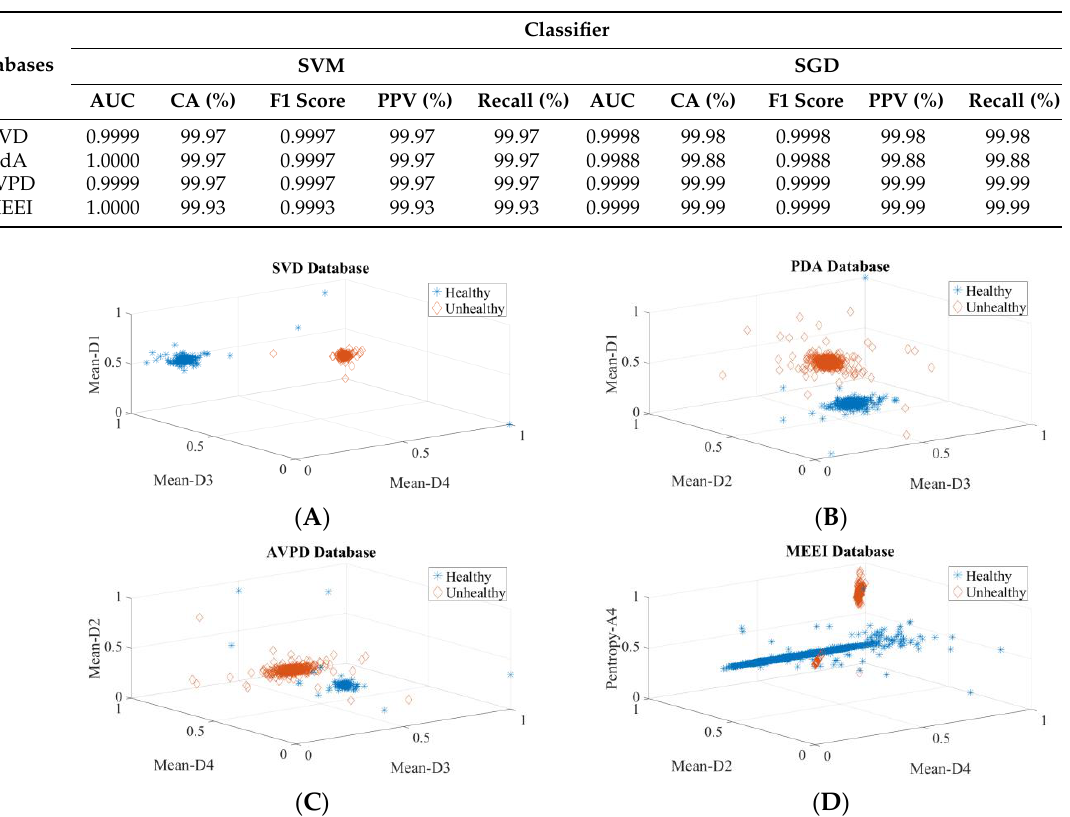
Figure 8. Three-dimensional scatter plots for each database’s top three descriptors: ( A ) Three-dimensional scatter plot of top three descriptors of SVD, ( B ) Three-dimensional scatter plot of top three descriptors of PdA, ( C ) Three-dimensional scatter plot of top three descriptors of AVPD, ( D ) Three-dimensional scatter plot of top three descriptors of MEEI.